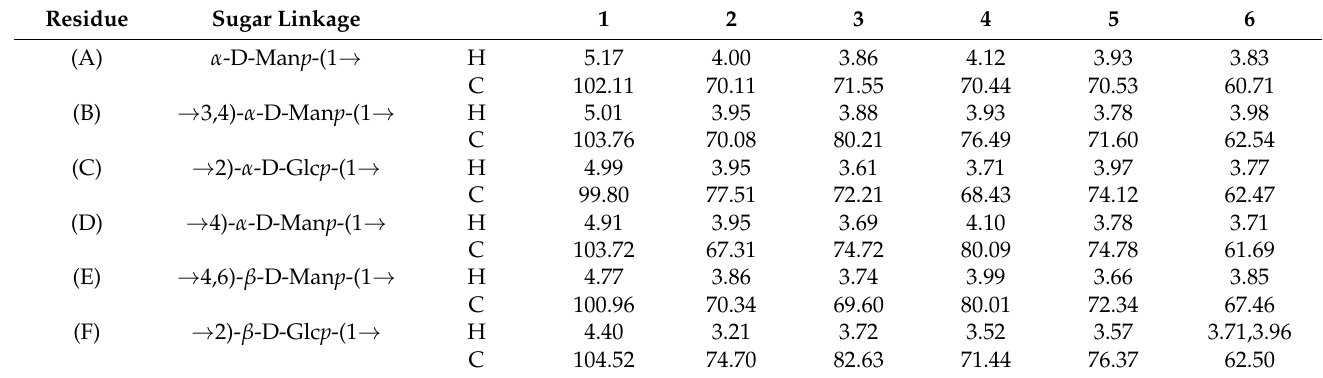
Table 1. 1 H and 13 C NMR spectrum assignments for S1 (ppm).